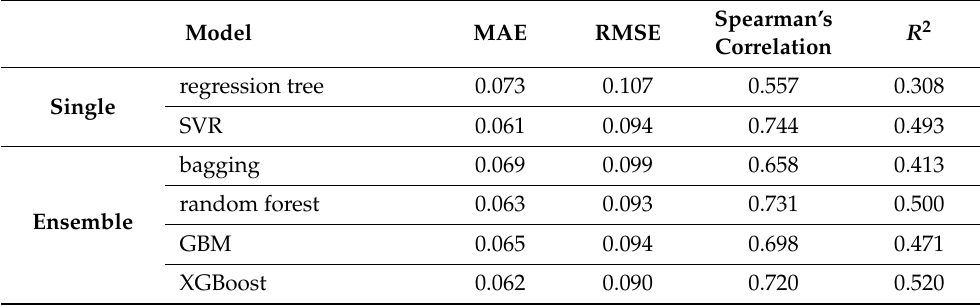
Figure 8. Boxplots of pH and transparency before and after imputation. ( a ) raw data of pH; ( b ) imputed data of pH; ( c ) raw data of transparency; ( d ) imputed data of transparency. The central lines in the boxes represent the median. The boxes encompass data between the 25th and 75th percentile; whiskers span the 5th and 95th percentiles. Values beyond these limits are represented as red asterisks. The dark pink circles in the boxes represent the means. Table 3. Prediction performance of the six machine learning models. Abbreviations: MAE, mean absolute error; RMSE, root mean square error; R 2 , coefficient of determination; SVR, support vector regression; GBM, gradient boosting machine; XGBoost, extreme gradient boosting. Spearman’s Model MAE RMSE R 2 Correlation regression tree 0.073 0.107 0.557 Single SVR 0.493 bagging 0.069 0.099 0.658 0.413 random forest 0.063 0.093 0.500 Ensemble GBM